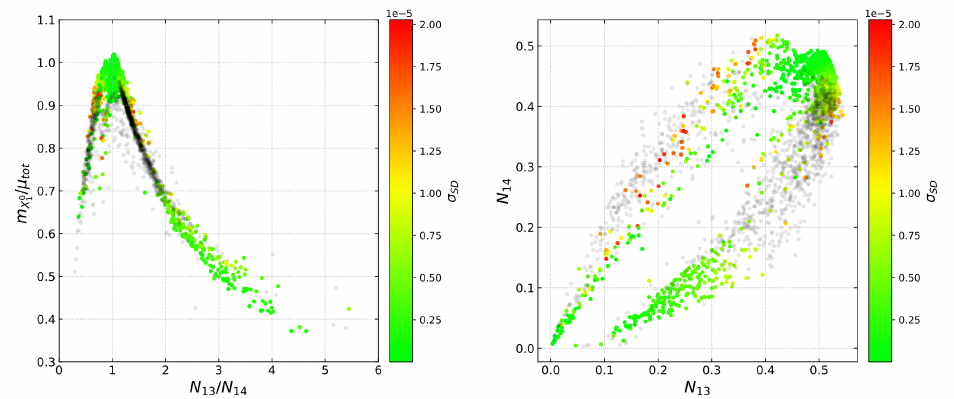
Figure 7 . The projection of all samples in figure 3 on N 13 /N 14 - m plot. Black samples in each plot are excluded by DM direct detection limits, and the others are surviving samples. For surviving samples, the colorbar in each plot represents σ to green color are much safer, samples close to red color are near DM direct detection